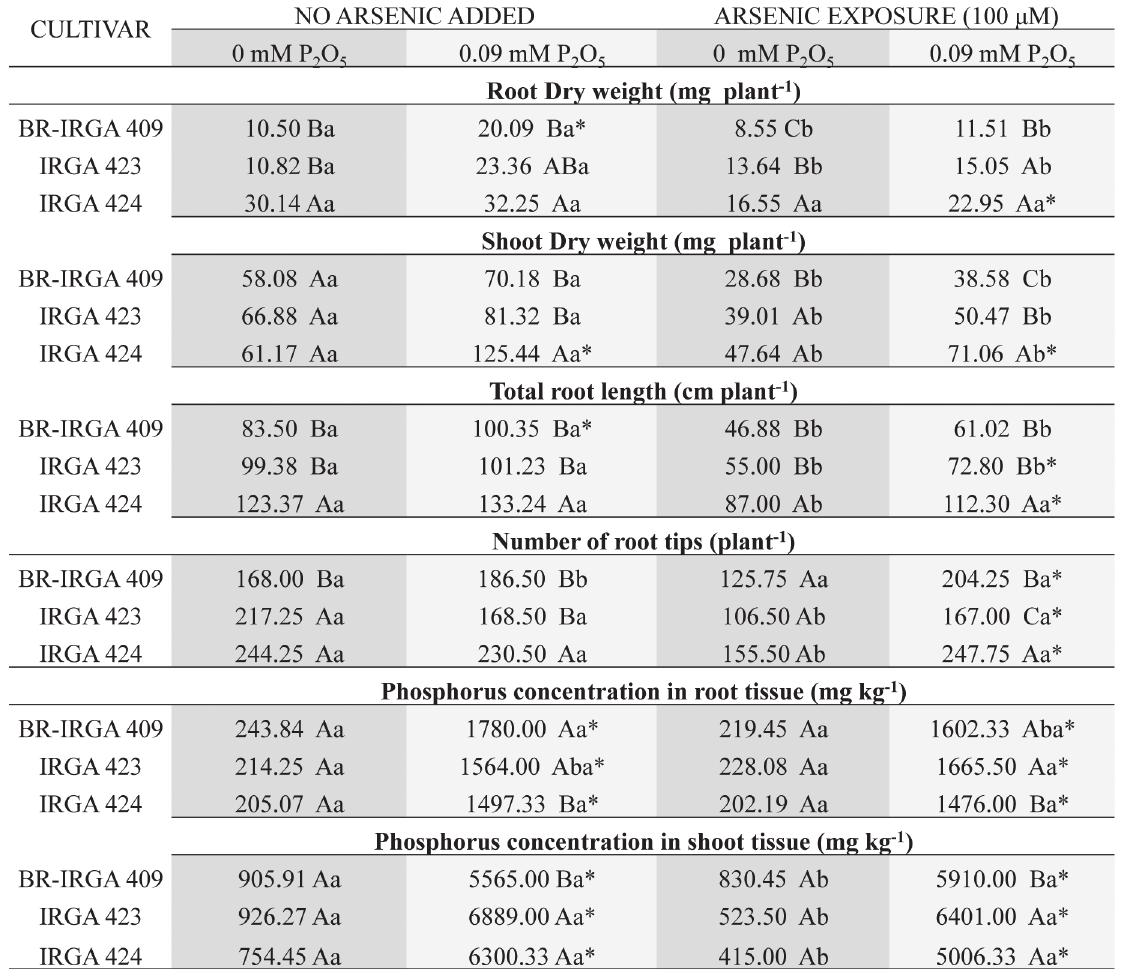
Figure 2 - Biomass and root system parameters of rice plants of three cultivars exposed to 100 μM arsenic and without arsenic, with phosphorus 0.09 mM and without phosphorus in nutrient solution. Means followed by capital letters indicate comparison between cultivars within the same phosphorus and arsenic levels, whereas lowercase letters indicate comparison of the arsenic exposure for the same cultivars and phosphorus level and asterisk indicate comparison between phosphorus levels for the same cultivar and arsenic exposure. Tukey test, α =